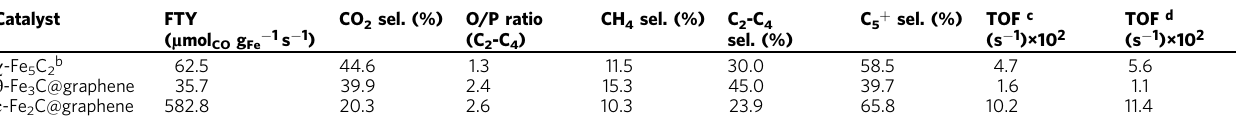
Table 1 Activity and hydrocarbon selectivity of different iron carbides catalysts for Fischer – Tropsch synthesis a .